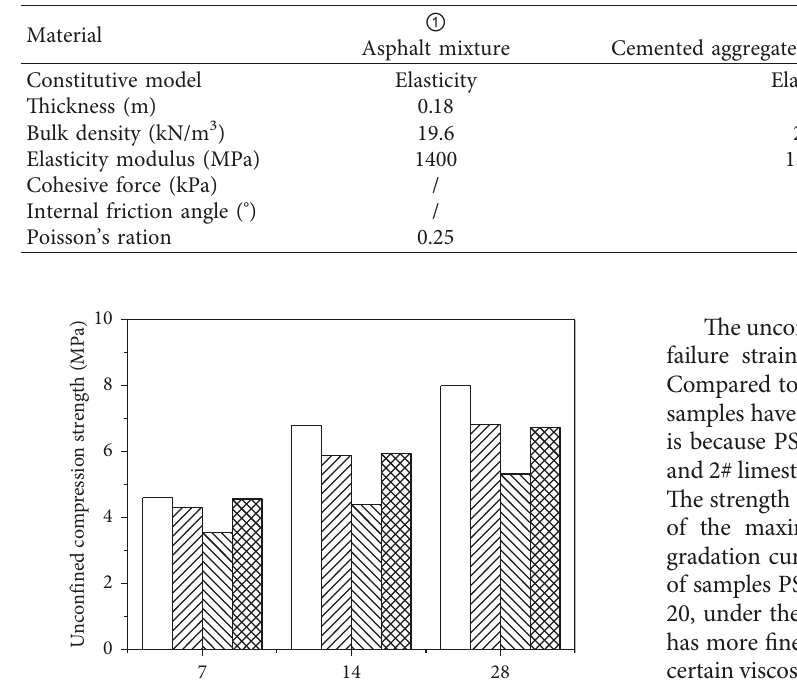
Table 4: Parameters of finite element model.